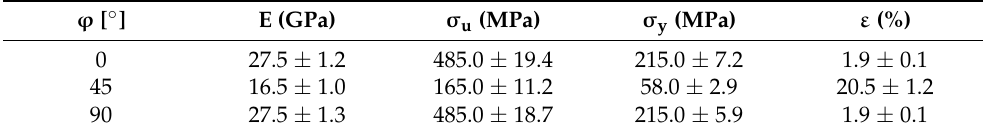
Table 1. Mechanical properties of woven fabric for the three different orientations: ϕ —fibers